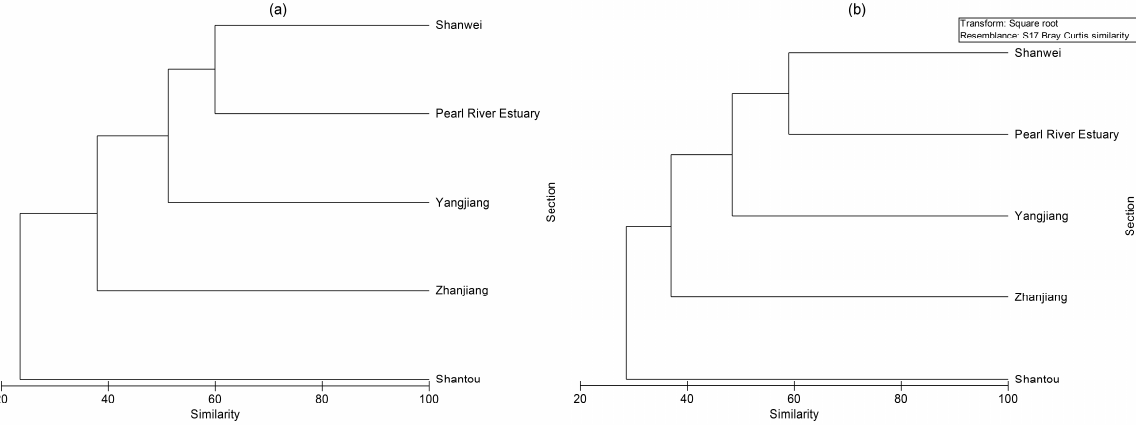
Figure 5. Seasonal and spatial variation in ( a ) biomass and ( b ) density of Evynnis cardinalis across the northern continental shelf, South China Sea.